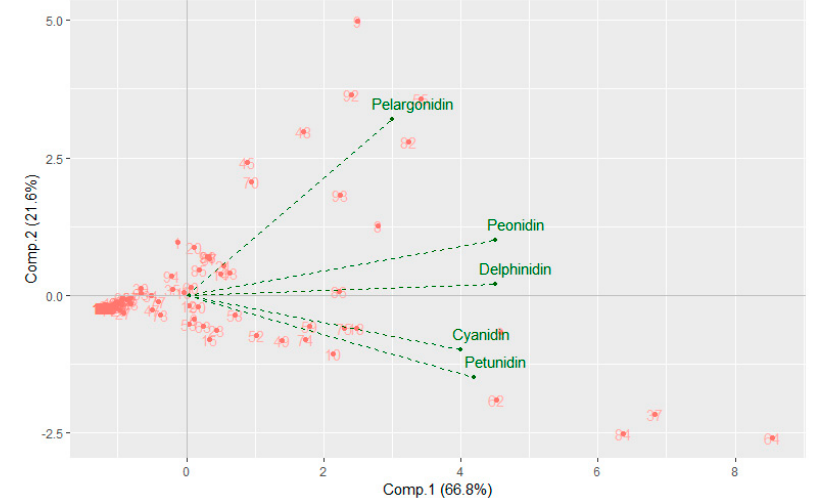
Figure 2. Principal component analysis-cluster analysis, over two principal components, of Solanum tuberosum L. accessions Group Phureja in cooked tubers. The direction of the vectors represents the anthocyanidins: petunidin, cyaniding, delphinidin, peonidin, and pelargonidin values.